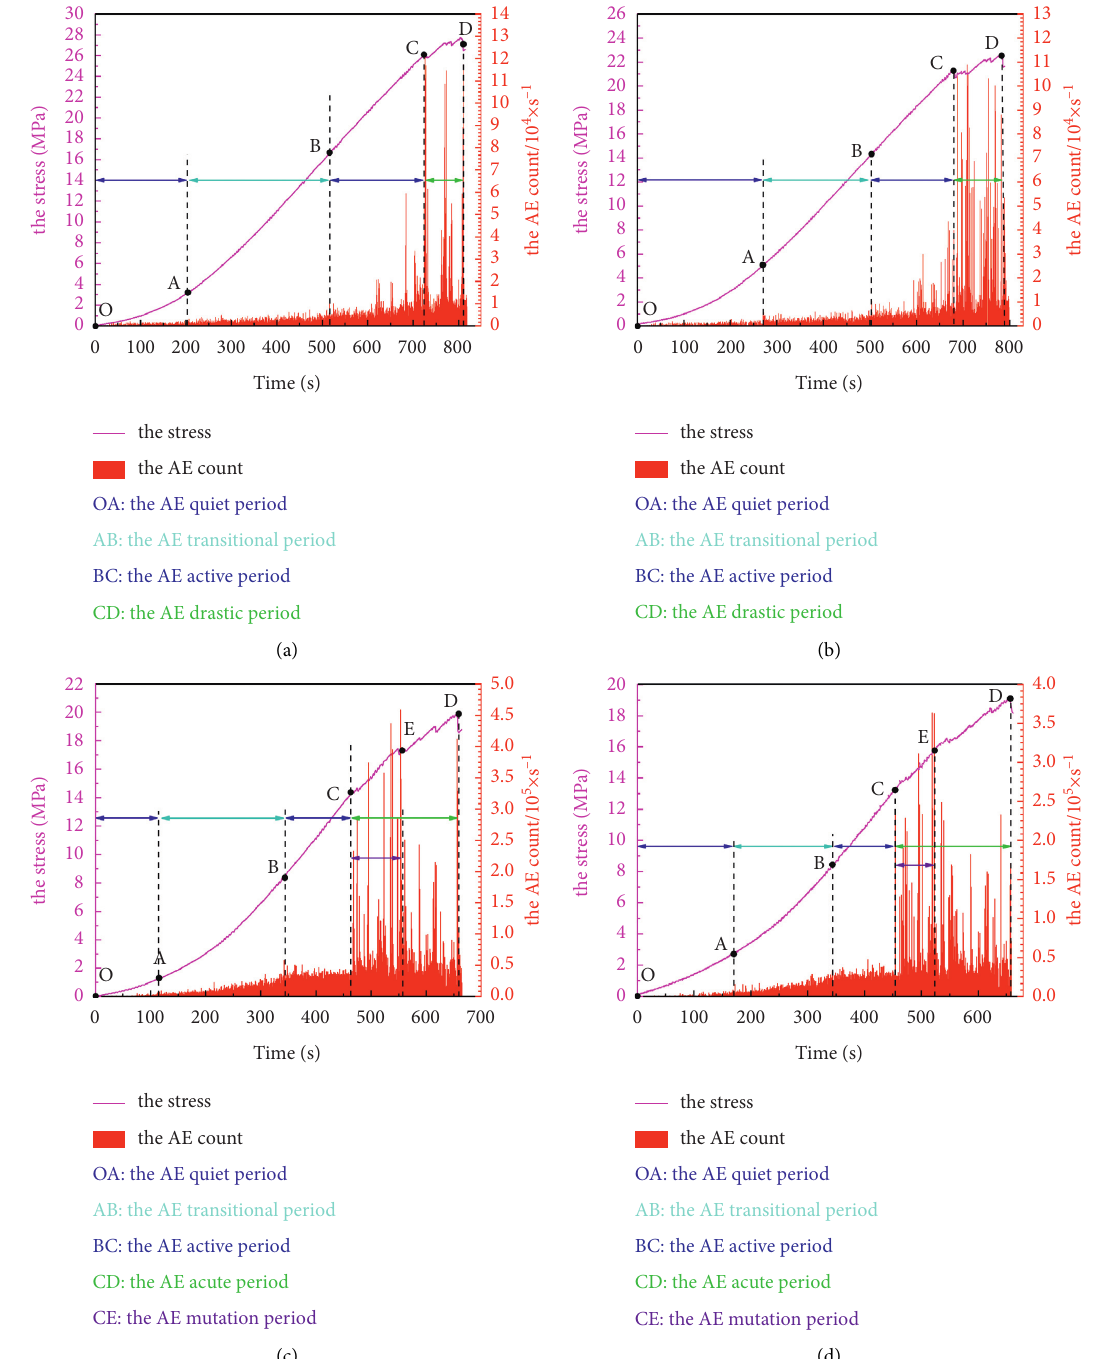
Figure 4: Acoustic emission parameter analysis of raw coal sample with parallel multibedding. (a) V1-1, (b) V1-2, (c) P2-1, and (d)